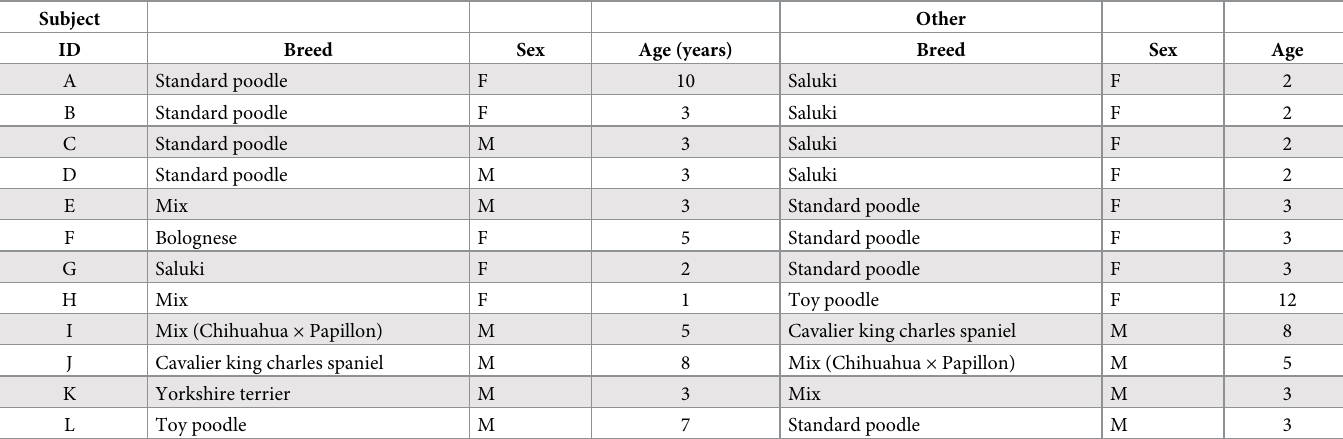
Table 1. Breed, sex, and age of the dogs tested in this